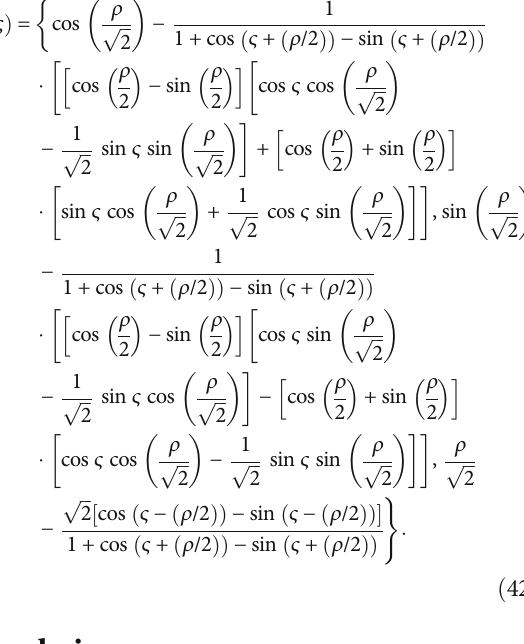
B -Darboux frame. 2 via